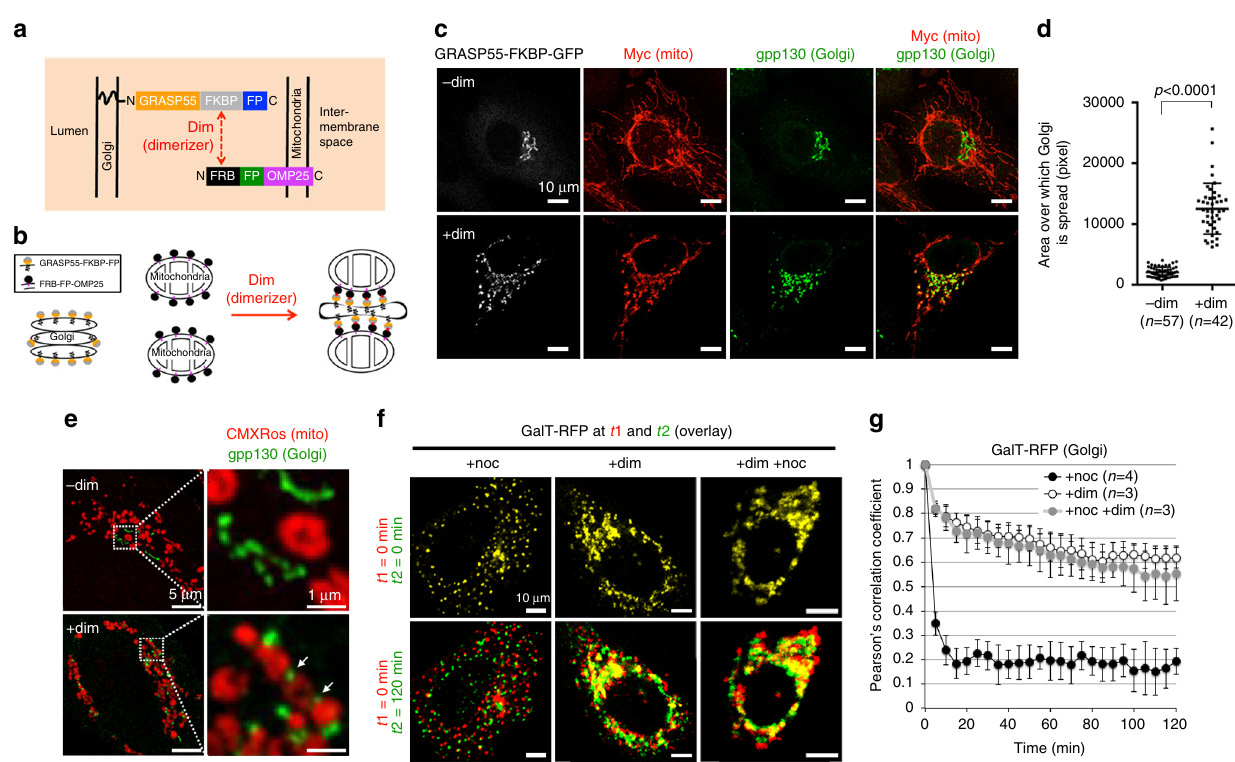
Fig. 1 Re-targeting GRASP55 from Golgi to mitochondria generates “ land-locked ” Golgi cisternae. a Schematic of GRASP55 re-targeting assay, adapted from Supplementary Fig. 8a 19 . GRASP55 is localized to the cytoplasmic face of the Golgi by N-terminal myristoylation. The C-terminal end of GRASP55 was fused to FKBP and a FP. OMP25 is anchored to the cytoplasmic face of the outer mitochondrial membrane by a C-terminal transmembrane domain. FRB and FP were fused to the N-terminal end of OMP25. Addition of the dimerizer induces FKBP and FRB heterodimerization. b Cartoon showing expected outcome of GRASP55 re-targeting to mitochondria. Addition of dimerizer induces heterodimerization of GRASP55-FKBP-BFP and FRB-FP-OMP25 leading to the adhesion of mitochondria to individual Golgi cisterna. c Confocal images of HeLa cells transfected with GRASP55-FKBP-GFP and FRB-Myc-OMP25 and immunostained for Myc and gpp130. Where indicated, cells were treated with dimerizer (2 μ M) for 3 h. Scale bar is 10 μ m. d Quanti fi cation of Golgi areas (gpp130 fl uorescence) with and without dimerizer from c . e STED microscopy images of thin section (70 nm) HeLa cells that were transfected with GRASP55-FKBP-HA and FRB-Myc-OMP25 and stained for mitochondria and immunostained for gpp130. Where indicated, cells were treated with dimerizer (2 μ M) for 3 h. Scale bar is 500 nm. f Live confocal imaging of Golgi in HeLa cells co-transfected with GalT-RFP, GRASP55-FKBP-BFP and FRB-GFP-OMP25, and pretreated with nocodazole, or dimerizer, or both. Overlay of frames from time 0 to time 0 and time 0 to time 120 min are shown. Scale bar is 10 μ m. g PCC over time t of overlay images of GalT-RFP at time 0 to time t based on live image movies from f . Error bars = s.d. For